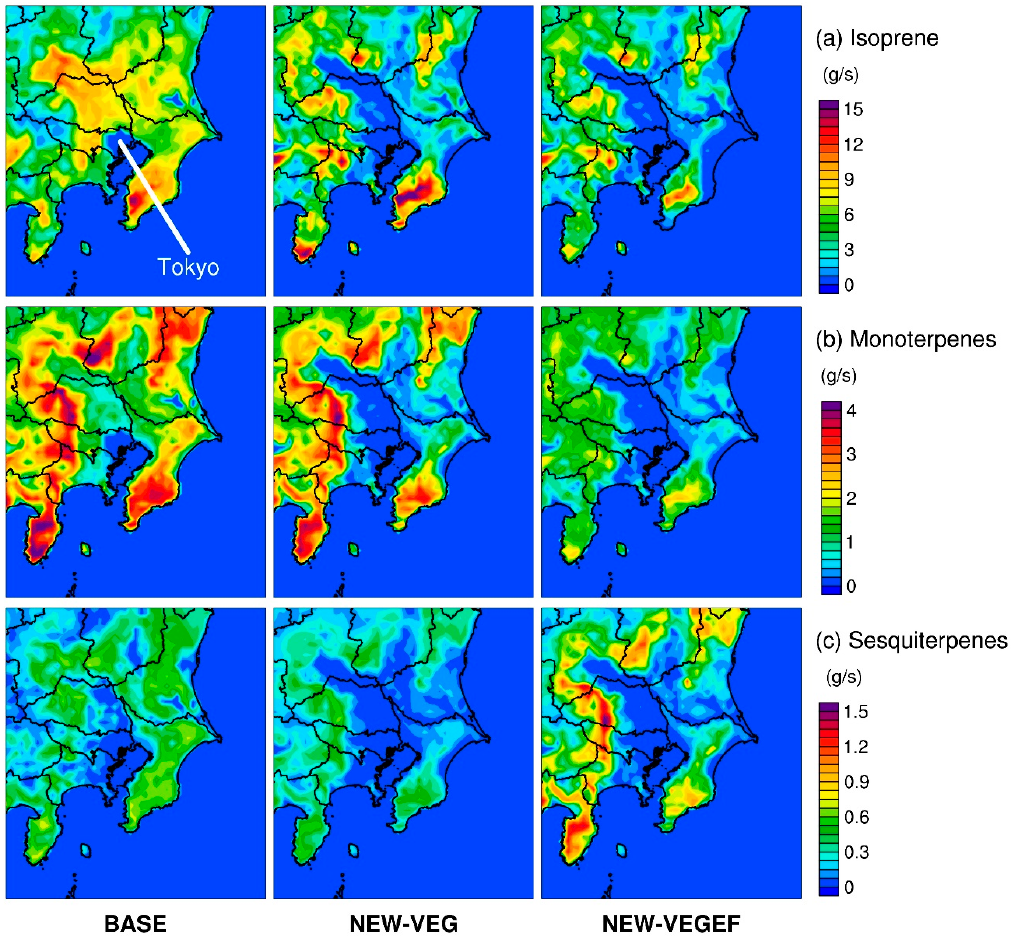
Figure 5. Horizontal distributions showing mean emission rates of ( a ) isoprene; ( b ) monoterpenes, and ( c ) sesquiterpenes estimated in BASE, NEW-VEG, and NEW-VEGEF cases during the target period in d04.